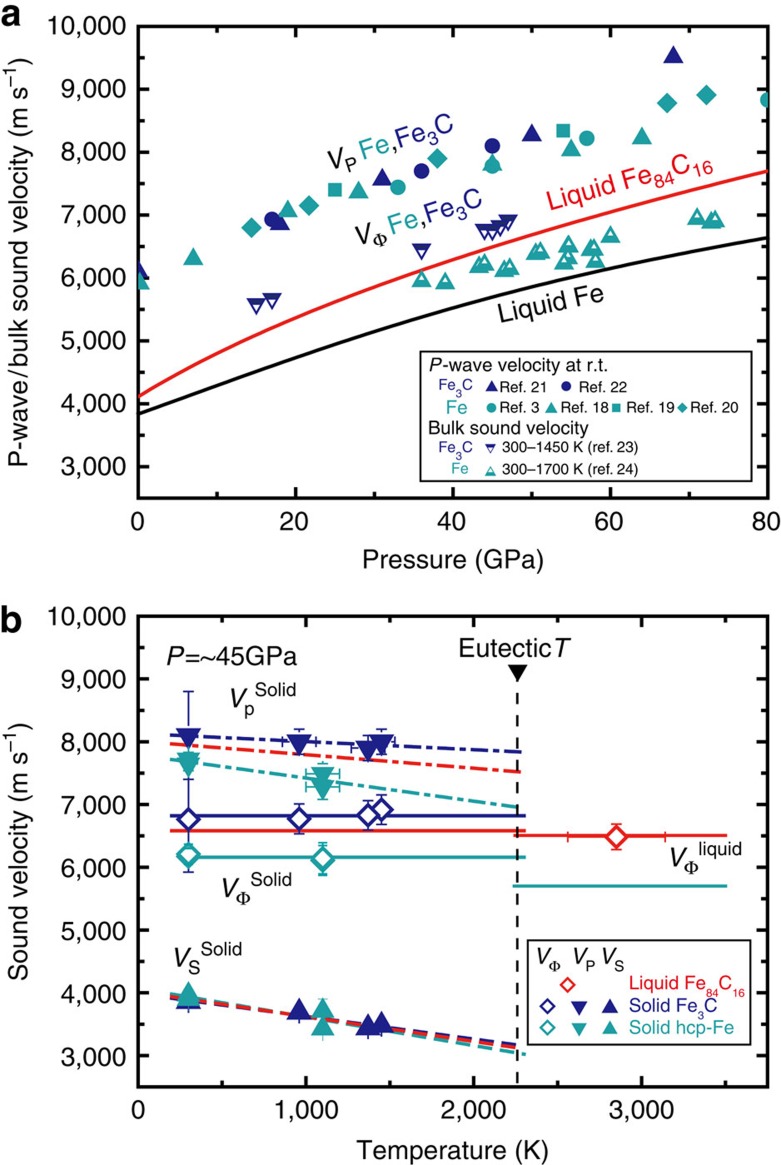
Comparison of velocities between liquid and solid Fe–C alloys.(a), P-wave velocities (VP) and bulk sound velocities (VΦ) of solid Fe (turquoise)318192024 and Fe3C (blue)212223 were determined by previous IXS and nuclear inelastic scattering (NIS) measurements. The VP for liquid Fe is from shock-wave study8. (b), Temperature effects on the sound velocities of Fe–C alloys at ∼45 GPa. The VP (= VΦ) of liquid Fe84C16 and liquid Fe is from the present work at 42 GPa and shock-wave data8, respectively. The VP, shear velocity (VS), and VΦ for solid Fe and Fe3C were reported by NIS measurements2324. Red lines for fictional solid Fe84C16 are estimated from a linear relationship between Fe and Fe3C.